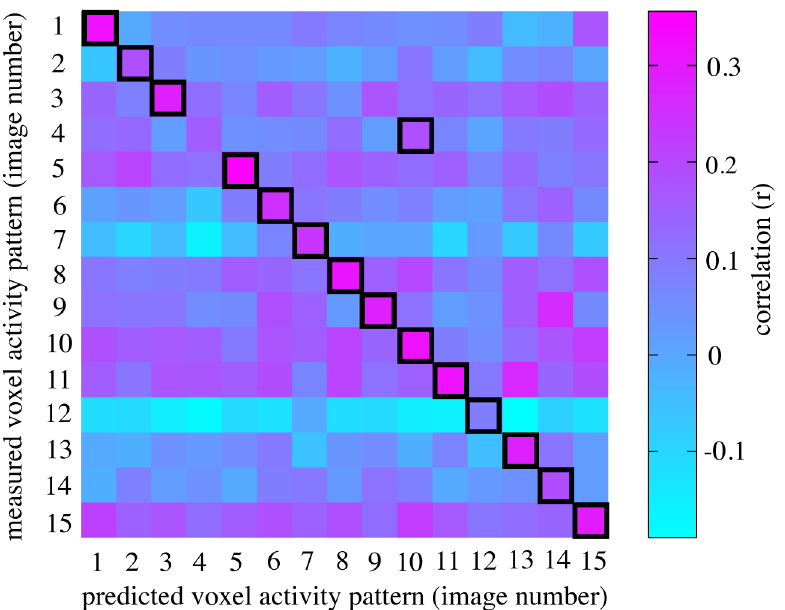
Fig 4. The correlation matrix for an example set of synthetic images. The correlationmatrix shows the prediction accuracy using the voxels of V1 from the image identification process for an exampleset of the synthetic images. The colors represent the correlation(Pearson’s r ) of the measured responseprofiles from all the images with their predictedresponseprofile (from the pRF-model). For this image set, 14 out of 15 images were identifiedcorrectly, giving a prediction accuracy of 93.3%.